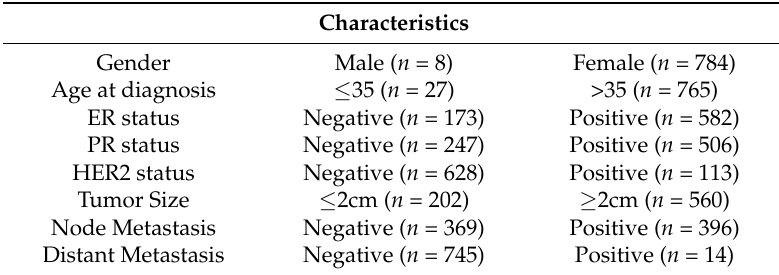
Table 3. Clinicopatholigical